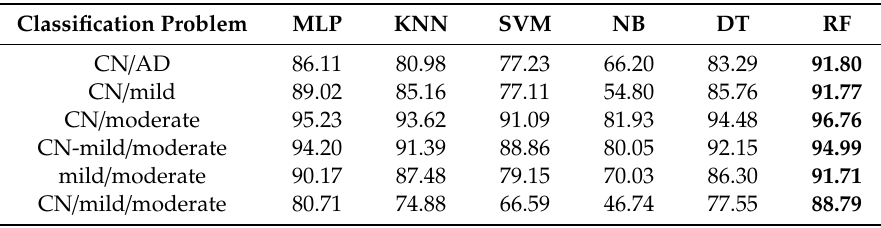
Table 2. The classification performance of MultiLayer Perceptron (MLP), k-Nearest Neighbor (KNN), Support Vector Machines (SVM), Naïve Bayes (NB), and Decision Trees (DT) for 12-s epochs in terms of